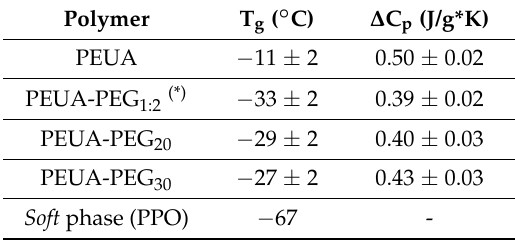
Table 1. Glass transition temperature (T g ) and variation of specific heat ( ∆ C p ) at the glass transition temperature for PEUA and PEG-functionalized polyurethanes. The glass transition temperature of the free soft phase (PPO) is also reported, for comparison. (*) The subscript indicates that the PEUA:PEG molar ratio employed during functionalization. Indeed, it was not possible to determine the functionalization degree for this polymer, as it is insoluble in common solvents.